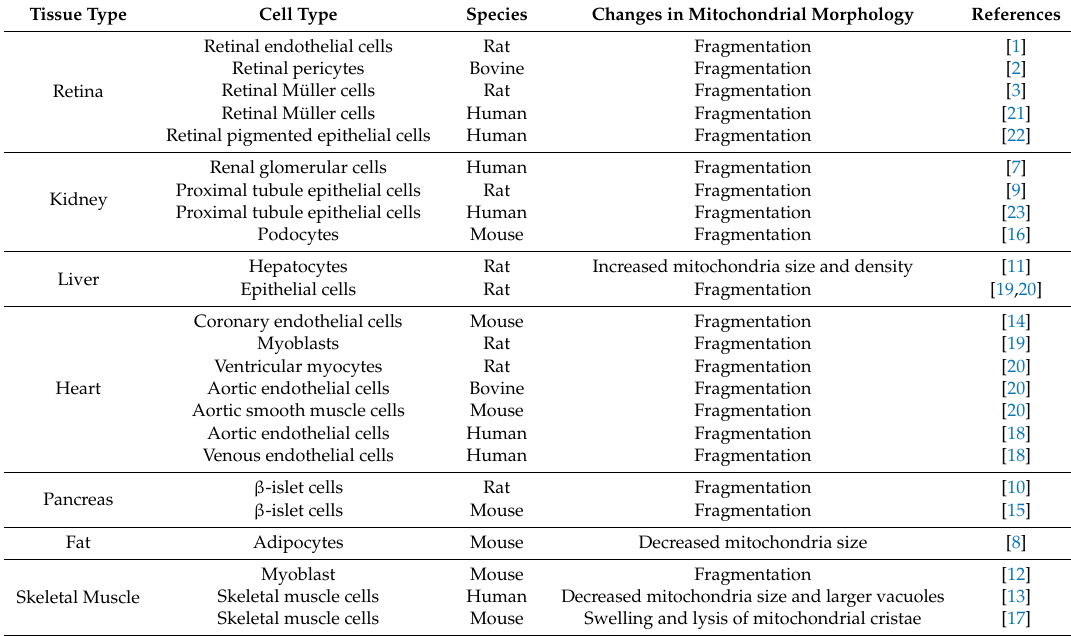
Table 1. Mitochondrial morphology changes in diabetic